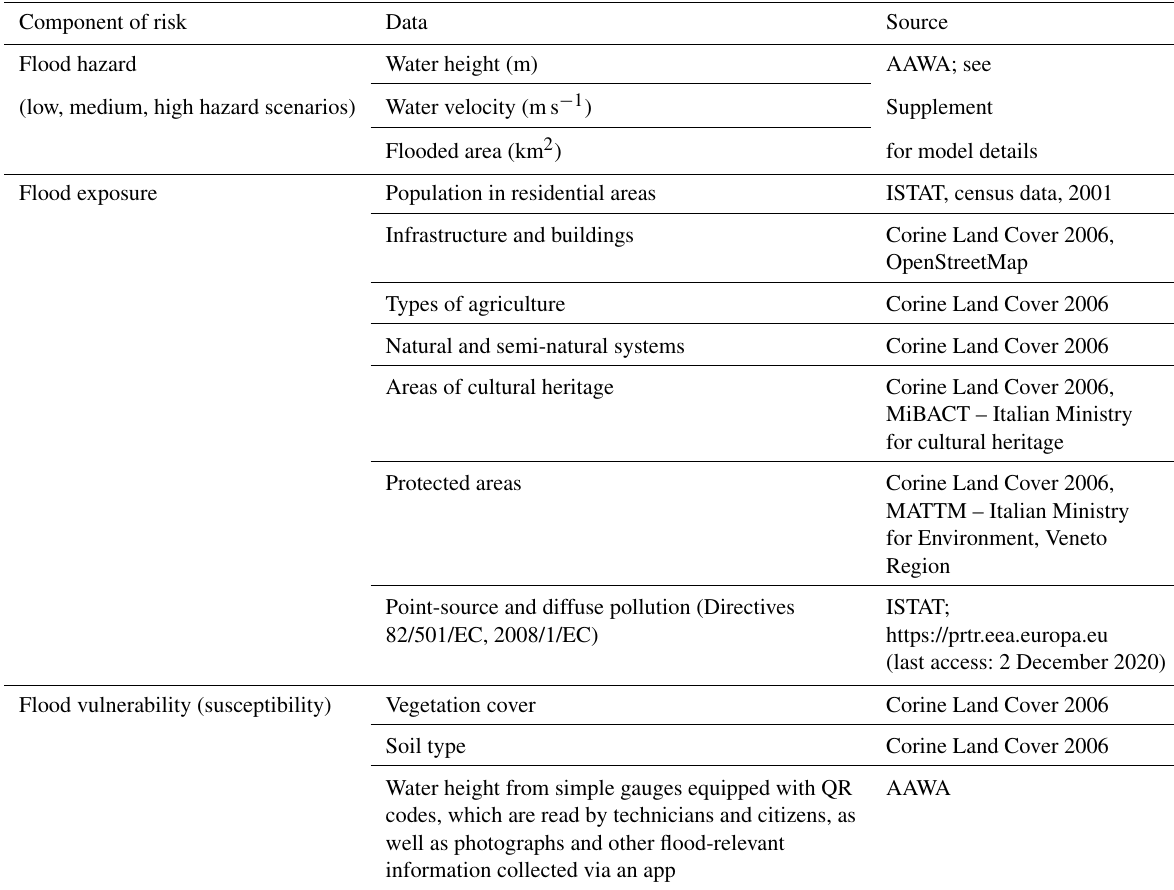
Table 1. Input data used to calculate risk.